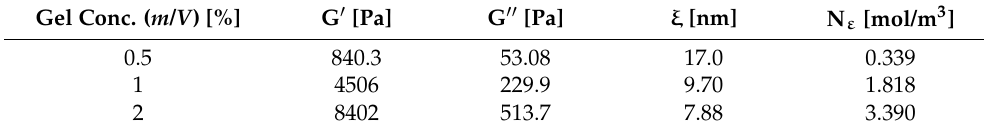
Table 2. Storage (G (cid:48) ) and loss moduli (G (cid:48)(cid:48) ) received from frequency sweep measurement and calculated from these measurements, the mesh size ( ξ ) and crosslink density (N ε